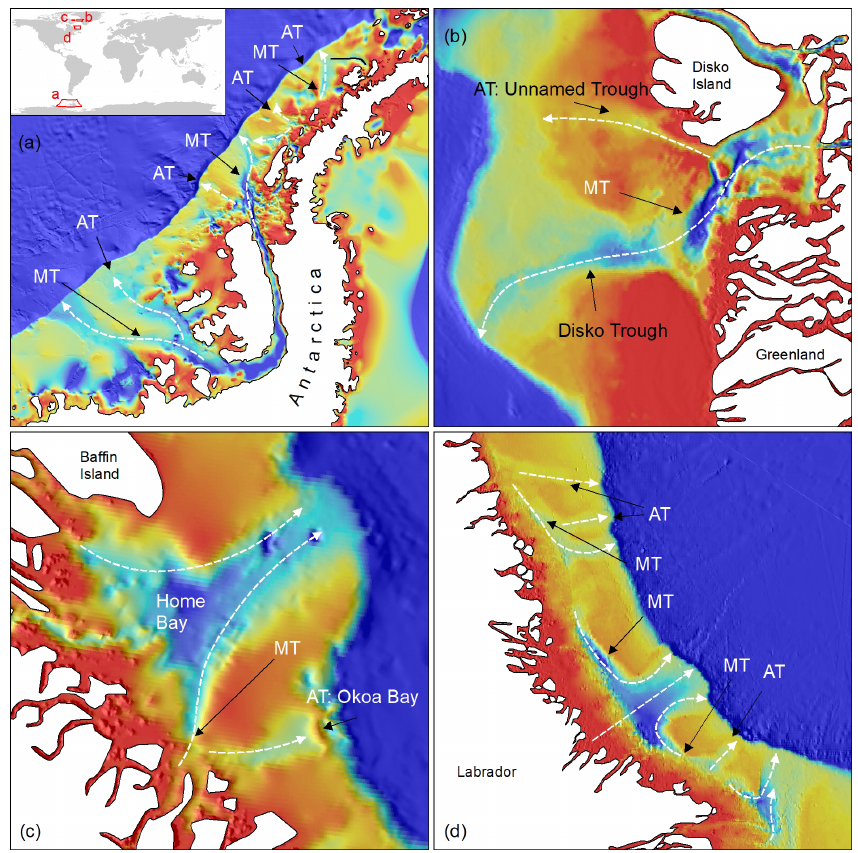
Figure 9. (a) Bathymetry (BEDMAP2; Fretwell et al., 2013) of the western continental shelf of the Antarctic Peninsula. MT: marginal trough. AT: abandoned trough. White dashed lines: interpreted ice-stream tracks. Inset: location of (a–d) . (b) Bathymetry (IBCAO) of an unnamed trough and Disko Trough off West Greenland. MT: Marginal trough. (c) Bathymetry (IBCAO) of Okoa Bay, Home Bay, and marginal troughs off eastern Baffin Island. (d) Bathymetry (IBCAO) of Labrador Shelf troughs off Labrador,